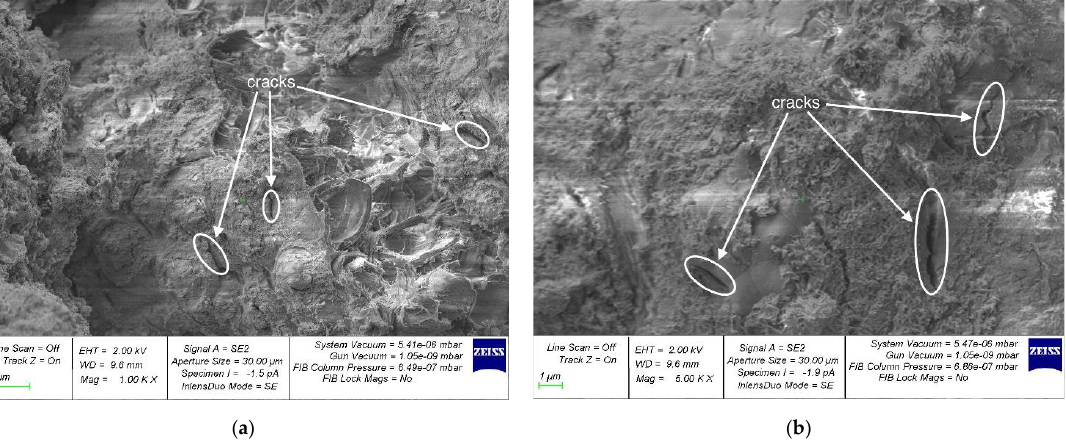
Figure 18. Photographs of the microstructure of a sample of hardened cement paste with dispersed reinforcement with coconut fibers in an amount of 2%: ( a ) 1000×; ( b ) 5000×. Figure 16 demonstrates the microstructural changes in the control composition after collapse. The structure was loose and had many voids. Figures 17 and 18 demonstrate that coir particulate reinforcement shortened the number of microcracks in the microstructure of the hardened cement paste. They restrained the stack propagation and, thanks to the bridging effect created by the fiber, bound the concrete matrix. The microstructure of hardened cement paste samples with a percentage of fiber reinforcement of 1.75% was the densest, practically not containing structural defects in the form of voids and cracks (Fig- ure 17). However, at a dosage of coconut fiber in an amount of 2%, due to their high water absorption, cracking was observed at the phase boundaries, which reduced the anchoring of the fiber in concrete (Figure 18). Figure 18 deserves special attention, since this area illustrates the nature of microcracking at the interfaces of the phases “ coconut fiber — ce- ment – sand matrix ” . By the nature of this microcracking, good compatibility of coconut fiber with the mineral matrix was visible. SEM analysis thus proved the expediency of dispersed reinforcement of cement systems with coconut fiber at the microstructural level. Thus, at the micro level, in the course of studying the structure formation of concretes reinforced with coconut fiber, it was established that the proper quality of the structure was maintained, the degree of cracking at the interface was low, and the fibers were well compatible with cement paste and other concrete components. Microstructural studies also confirmed the effectiveness of concrete reinforcement with dispersed fibers. In view of the formation of the concrete structure at the micro and macro levels, un- der the condition of a uniform distribution of coconut fibers in the mixture, a rational concentration of crystallization centers occurred throughout the entire volume of the com- posite. Good chemical compatibility of coconut fibers with hydration products and a high degree of mechanical anchoring of the fibers in the cement – sand matrix contributed to the high final strength characteristics of concrete and the expansion of its serviceability. Compared with the results of other authors, we achieved high values of the SC of concrete reinforced with coconut fibers. In [5], the authors achieved an increase in the axial tensile strength of concrete up to 30.63% due to the FDRC with coconut fibers. The tech- nology we used and composition recommendations gave an increase in the axial tensile strength of concrete up to 43%. In [43], the authors managed to obtain an increase in tensile strength in bending up to 45% by adding coconut fibers and recycled filler from 16% to 45%. In our study, by using only coconut fibers, it was possible to achieve an increase in the tensile strength in bending of concrete up to 42%, which approximately corresponded to the increase achieved in [43]. The augmentation of compressive strength up to 26% ex- ceeded the gains achieved in [45], namely, 12%. The effective dosage of coconut fibers